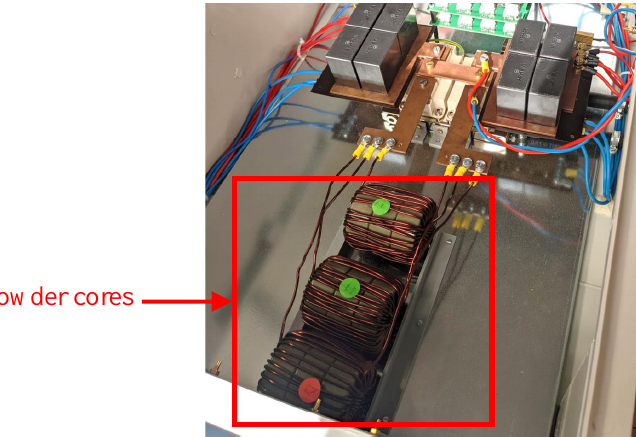
Figure 11. Powder cores of the experimental setup.